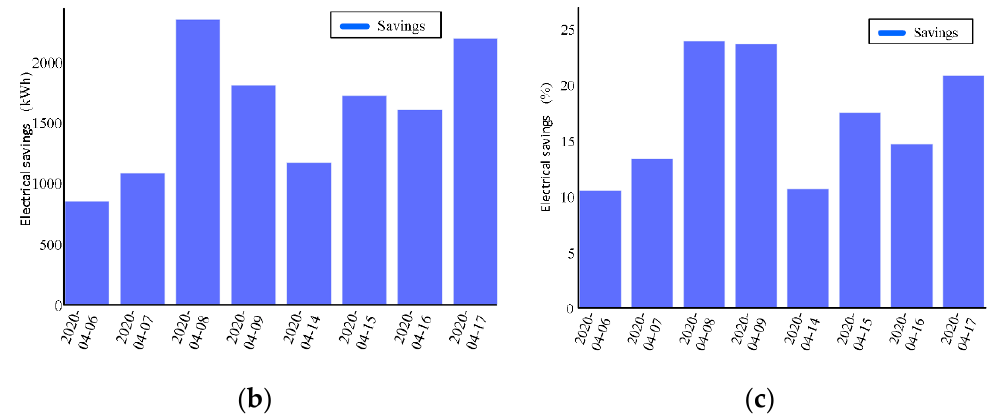
Figure 12. Electrical consumption results. ( a ) Electrical energy consumption of the proposed method compared with the reference. ( b ) Energy saved with the proposed method vs. reference. ( c ) Percentage of energy that it supposes.